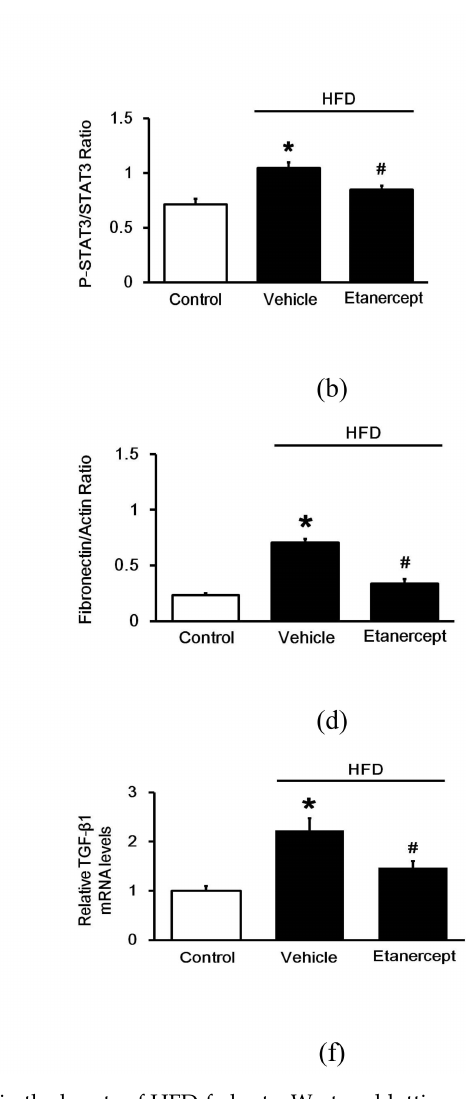
Figure 3. Effects of etanercept on fibrosis-related gene expression in the hearts of HFD-fed rats. Western blotting analysis of each protein in the myocardium from the normal control rats (Control), HFD-fed rats (Vehicle), and etanercept- treated HFD-fed rats (Etanercept) were compared; p-STAT3, STAT3, CTGF, and fibronectin were measured. Representative blots are presented ( a ); and the quantification of each signal, including STAT3 activation (p-STAT3/STAT3) ( b ), CTGF ( c ), and fibronectin ( d ) relative to the internal control was performed for comparison. The mRNA levels of NFkB ( e ) and TGF- β 1 ( f ) were also measured using real-time qPCR. The results are presented as the mean ± standard deviation ( n = 4 per group). * p < 0.05 compared with the control rats and # p < 0.05 compared with the vehicle treated rats, one-way ANOVA, followed by Bonferroni test. p-STAT3, phosphorylated signal transducer and activator of transcription 3; CTGF, connective tissue growth factor; NFkB, nuclear factor kappa-light-chain-enhancer of activated B cells; TGF- β 1, transforming Growth Factor Beta1; qPCR, quantitative polymerase chain